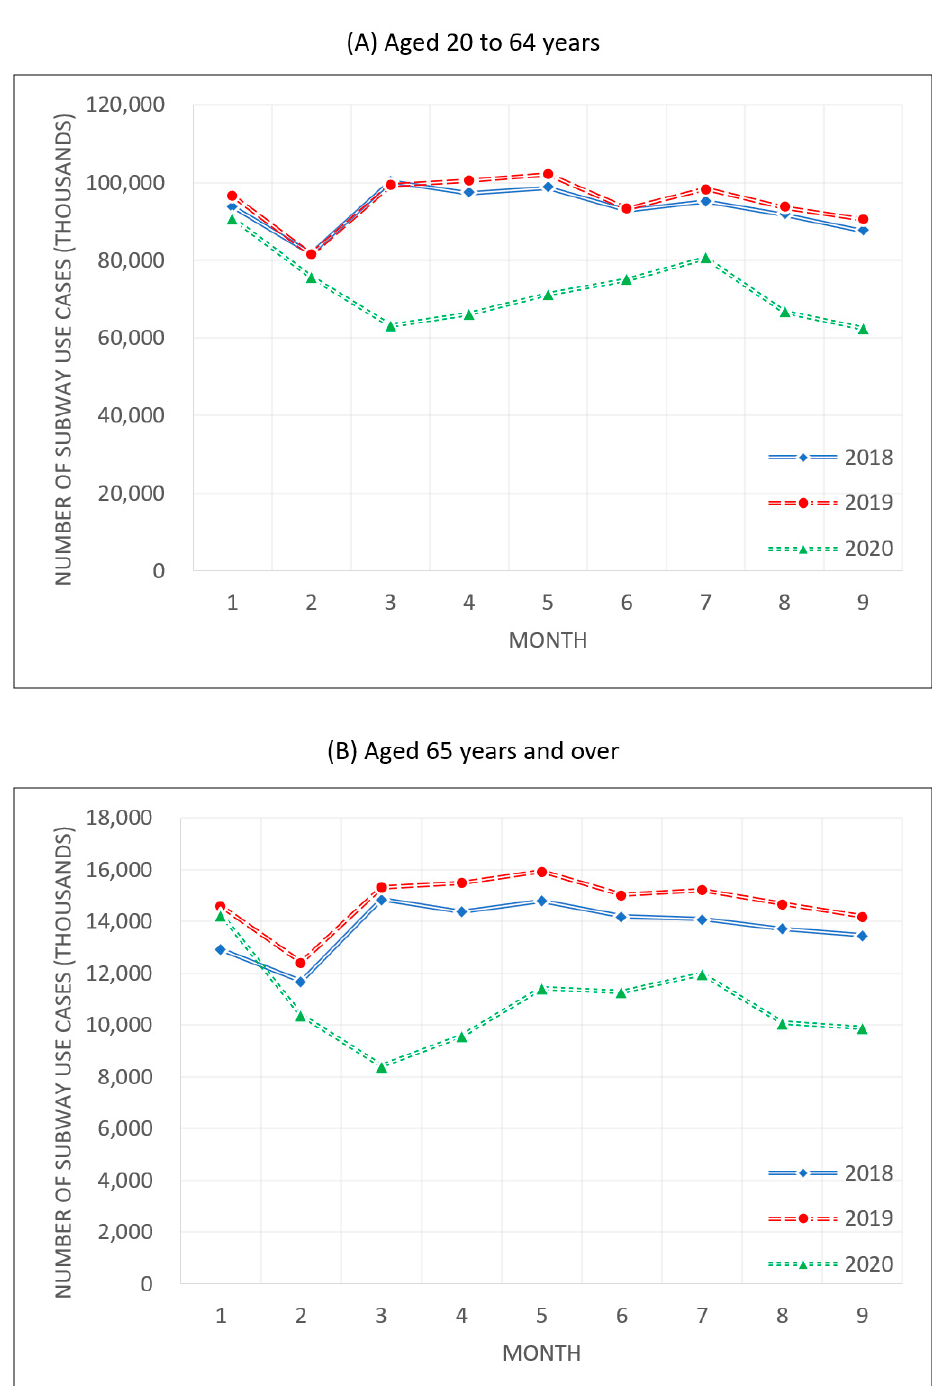
Figure 7. Number of subway uses during 2018–2020.